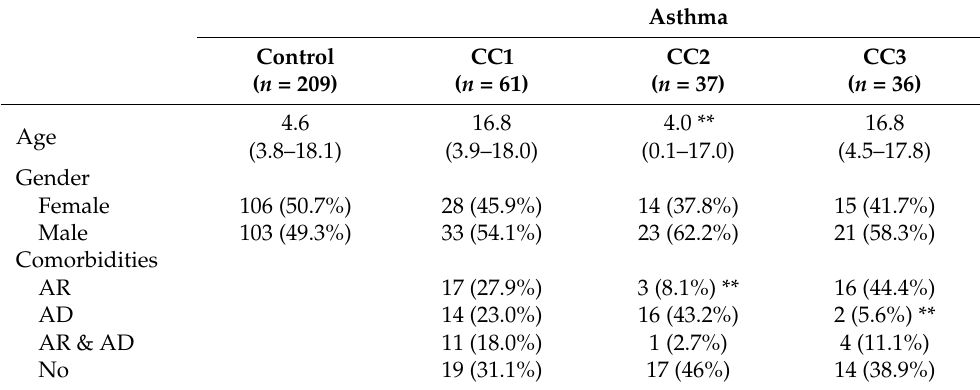
Table 1. Clinical characteristics of patients with pediatric/adolescent